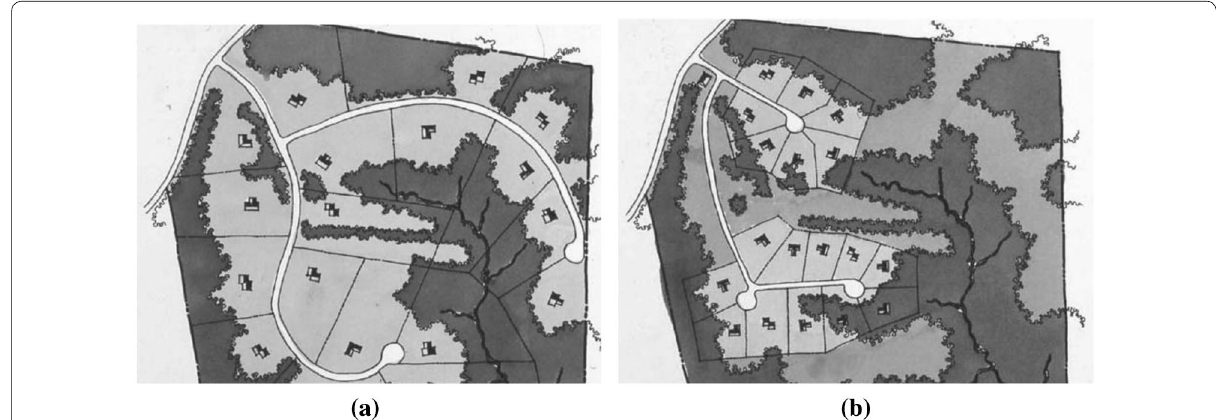
Fig. 10 Comparison of conventional and cluster developments (Kashef 2009). a Conventional development. b Cluster development